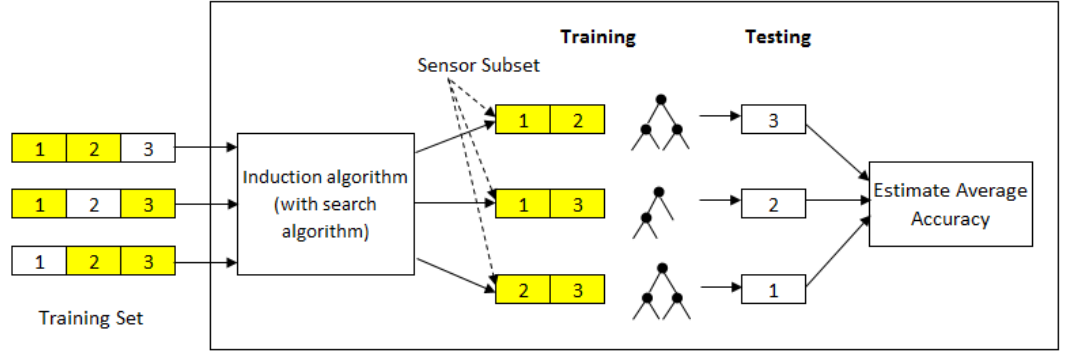
Figure 1. Wrapper-based sensor selection using 3-fold